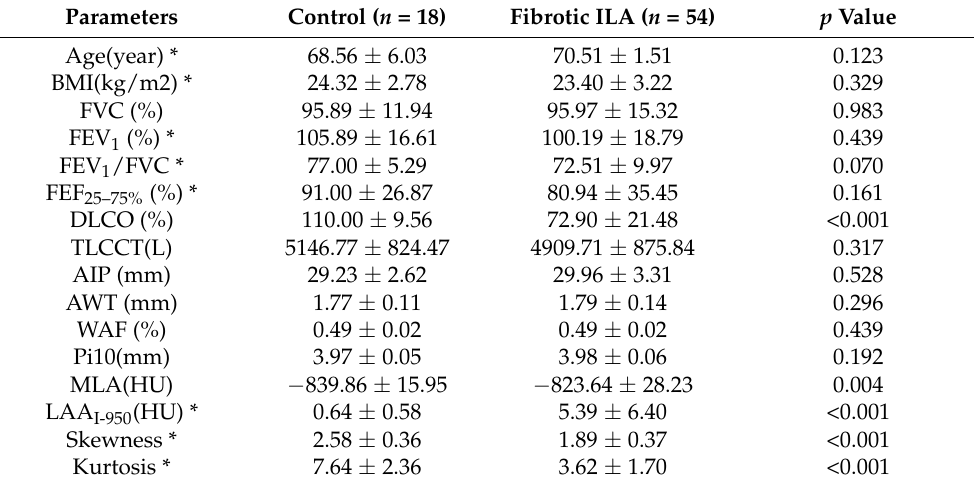
Table 1. Compared Control Subjects with Fibrotic Interstitial Lung Abnormality Patients in Pul- monary Function Tests and Quantitative CT